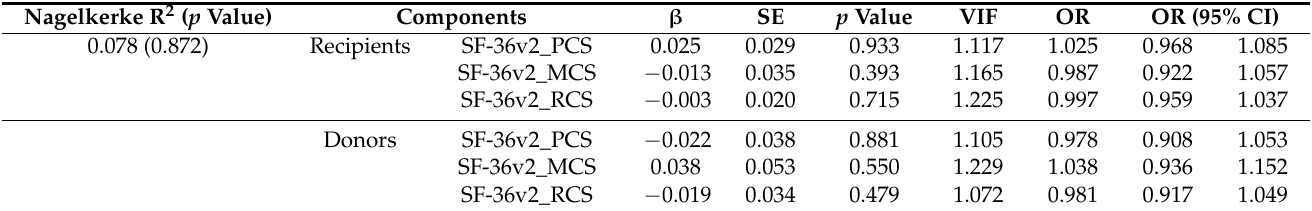
Table 2. Impact components of SF-36v2 on choosing between PEKT and PDKT for recipients and donors analysed using binomial logistic regulation analysis with robust standard errors. β means standard partial regression coefficient. SE: standard Error. VIF: Variance Inflation Factor. OR: Odds Ration. Nagelkerke R 2 ( p